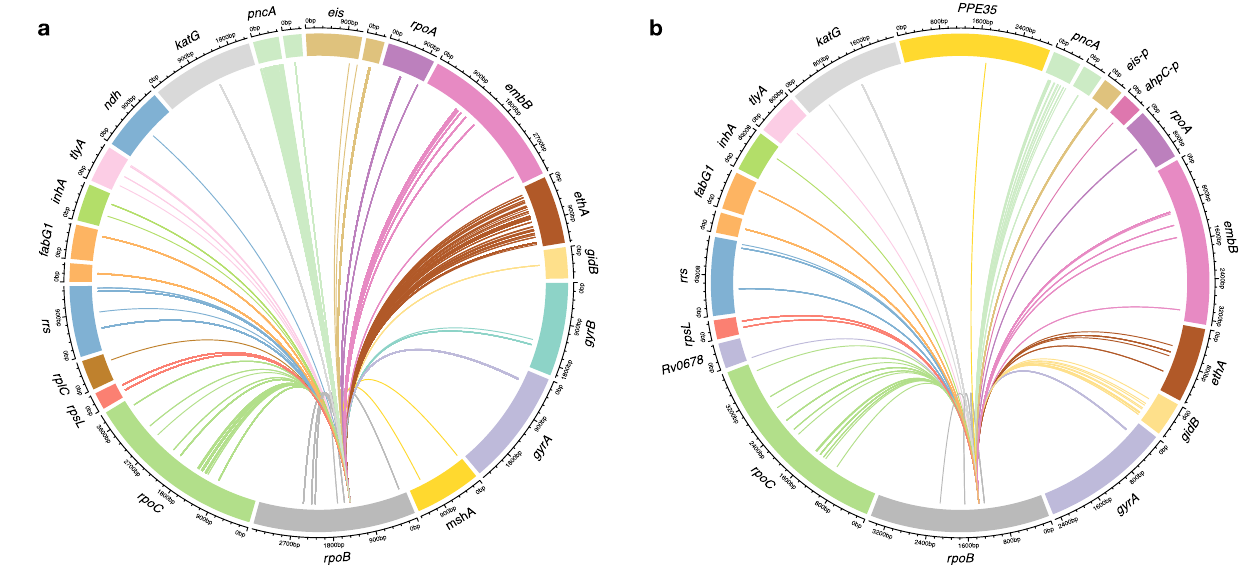
Fig. 6 | Interactions with additional drug resistance-related mutations and compensatory mutations in MDR M. tuberculosis L2 and L4 strains that carry the RpoB S450L mutation. Co-occurrence patterns of RpoB S450L with other resistance-conferring and compensatory mutations in the L2 ( a ) and L4